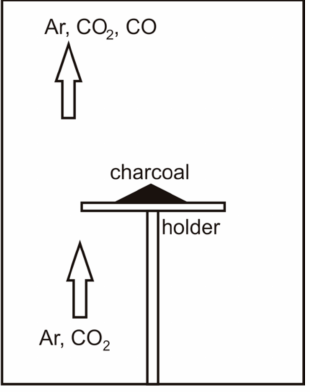
Figure 1. Scheme of thermogravimetric